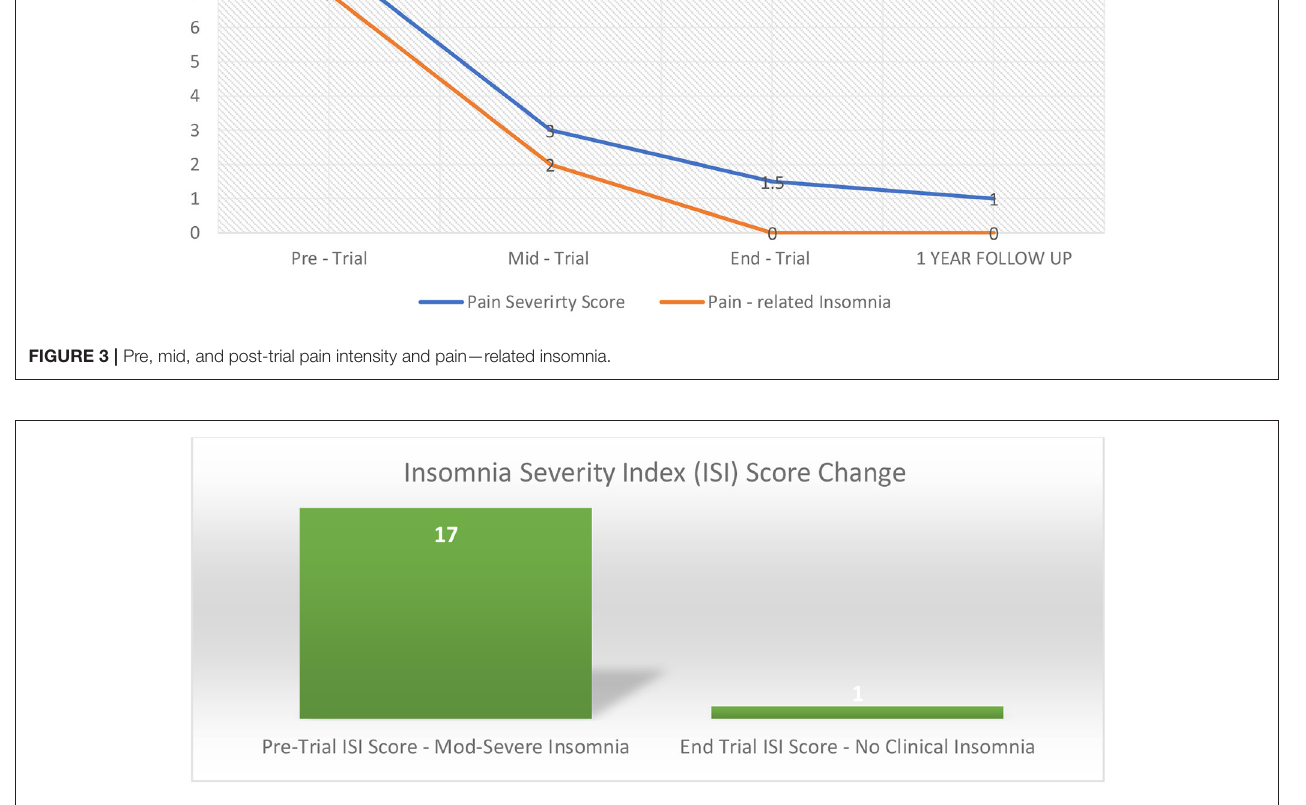
FIGURE 4 | Insomnia severity index score change pre and end